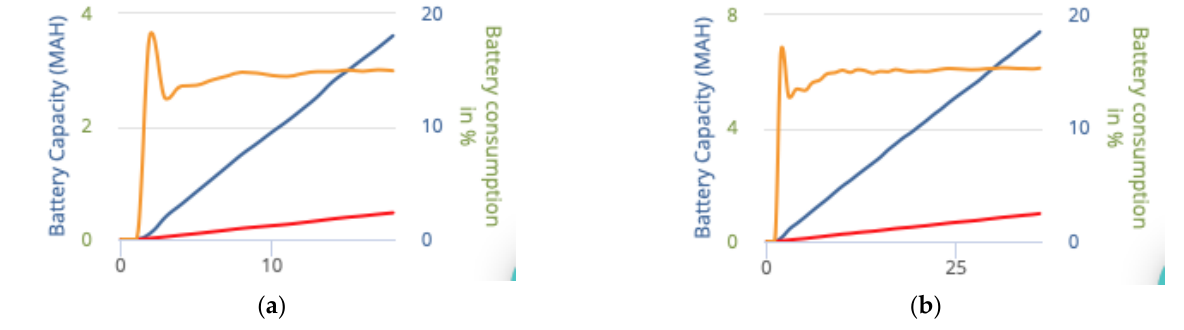
Figure 18. Battery consumption in % of device and mAh of ( a ) Median-36 and ( b ) Kalman-36 implementation (time axis in minutes).